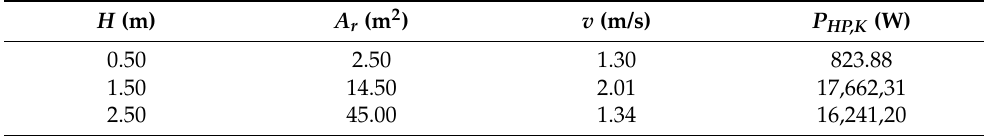
Table 7. Insight into the potential power of the turbines with respect of the kinetic hydro energy for the Mirna